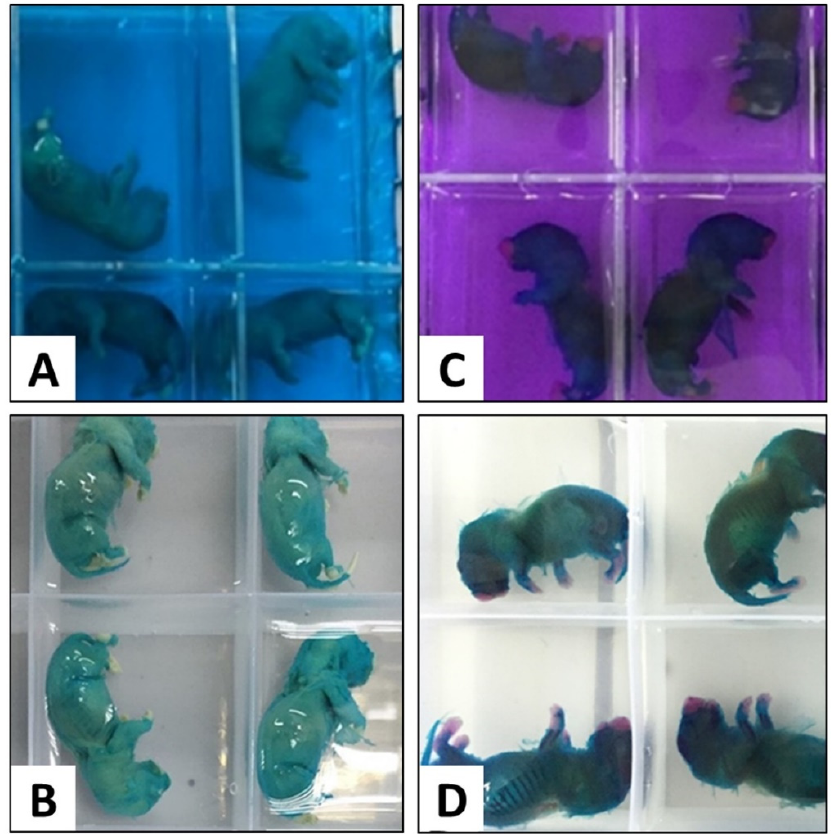
Figure 2. Staining of cartilage using Alcian Blue ( A ); Rehydration of foetal specimens in a descending series of concentration of ethanol ( B ); Staining of bone using Alizarin Red S solution ( C ); Clearing with KOH ( D ).